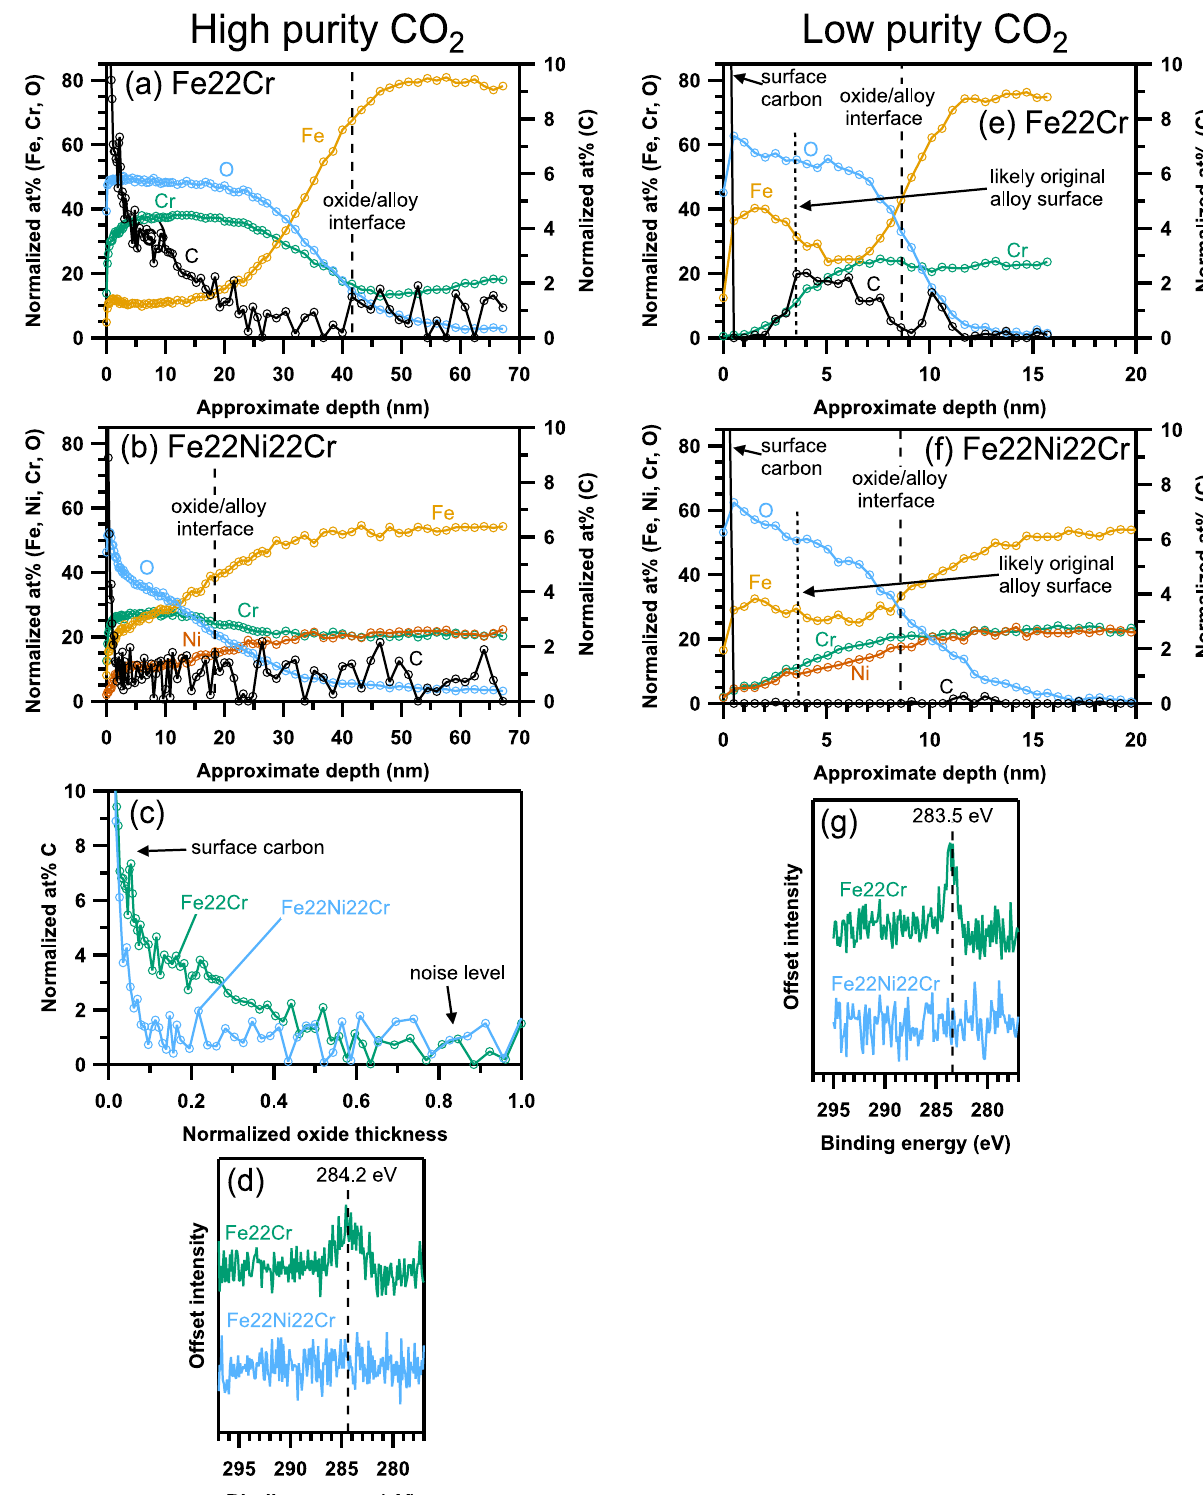
Fig. 10 XPS sputter depth pro fi les collected after AP-XPS experiments. a , b Depth pro fi les for samples exposed in high purity CO 2 . c Atomic percentage of C as a function of the normalized thickness of the oxide layer. d C 1s spectra at a normalized oxide depth of 0.25. e, f Depth pro fi les for samples exposed in low purity CO 2 . g C 1s spectra at a depth of 4.6 nm. The approximate oxide/alloy interface is indicated for each